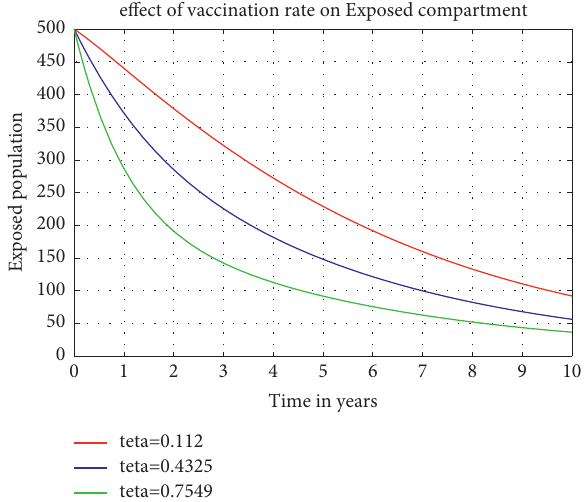
Figure 18: Effect of vaccination rate on exposed